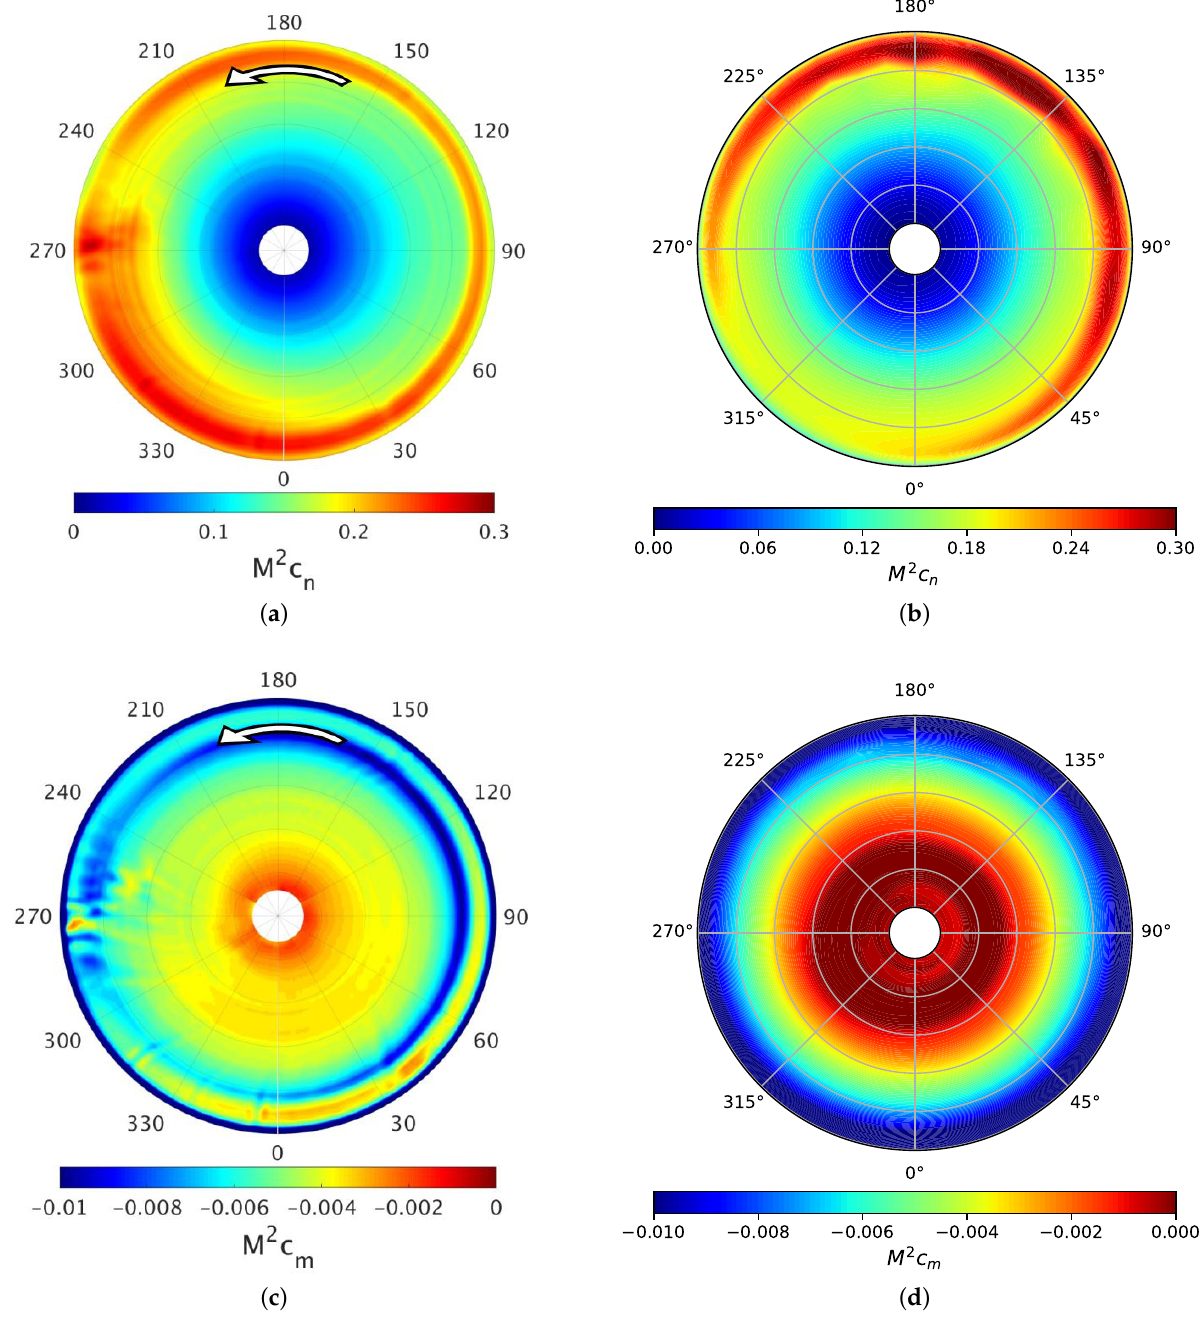
Figure 15. Comparison of the contours of the non-dimensional normal force M 2 c n and pitching moment M 2 c m on the proprotor blade in hover, θ N = 90 ◦ , Ω = 589 RPM. ( a ) M 2 c n : CFD [17]; ( b ) M 2 c n : DUST; ( c ) M 2 c m : CFD [17]; ( d ) M 2 c m :